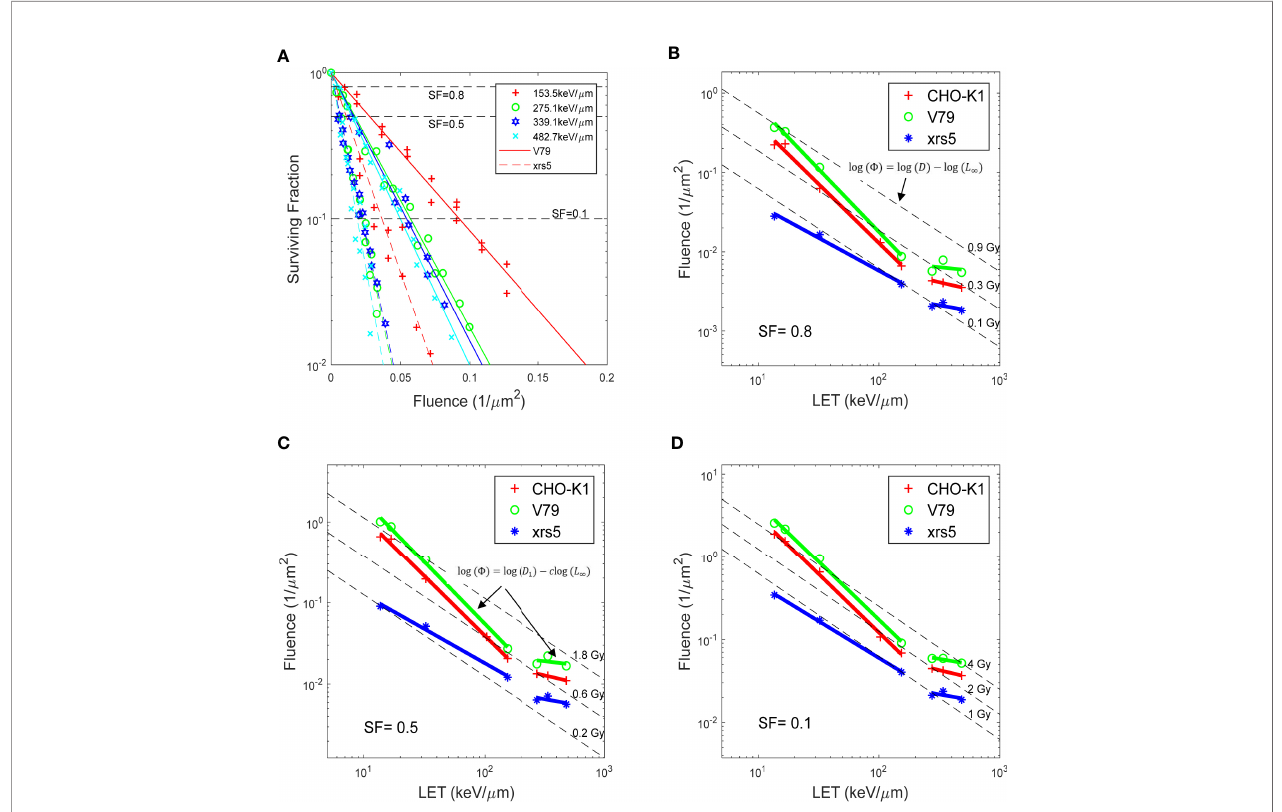
FIGURE 1 | (A) Fluence vs. SF for V79 and xrs5 cells, for carbon irradiation with different LET. The same marker represents the same LET carbon irradiation, solid and dash lines are the fi tted response for V79 and xrs5 cells, respectively. (B-D) show at survival fractionation of 0.8, 0.5 and 0.1, respectively, the fl uence needed for various LET beams to achieve the survival fractionation, for three different cell lines. Also plotted are relevant dose levels for the corresponding survival fractionations. Data extracted from Weyrather et. al.